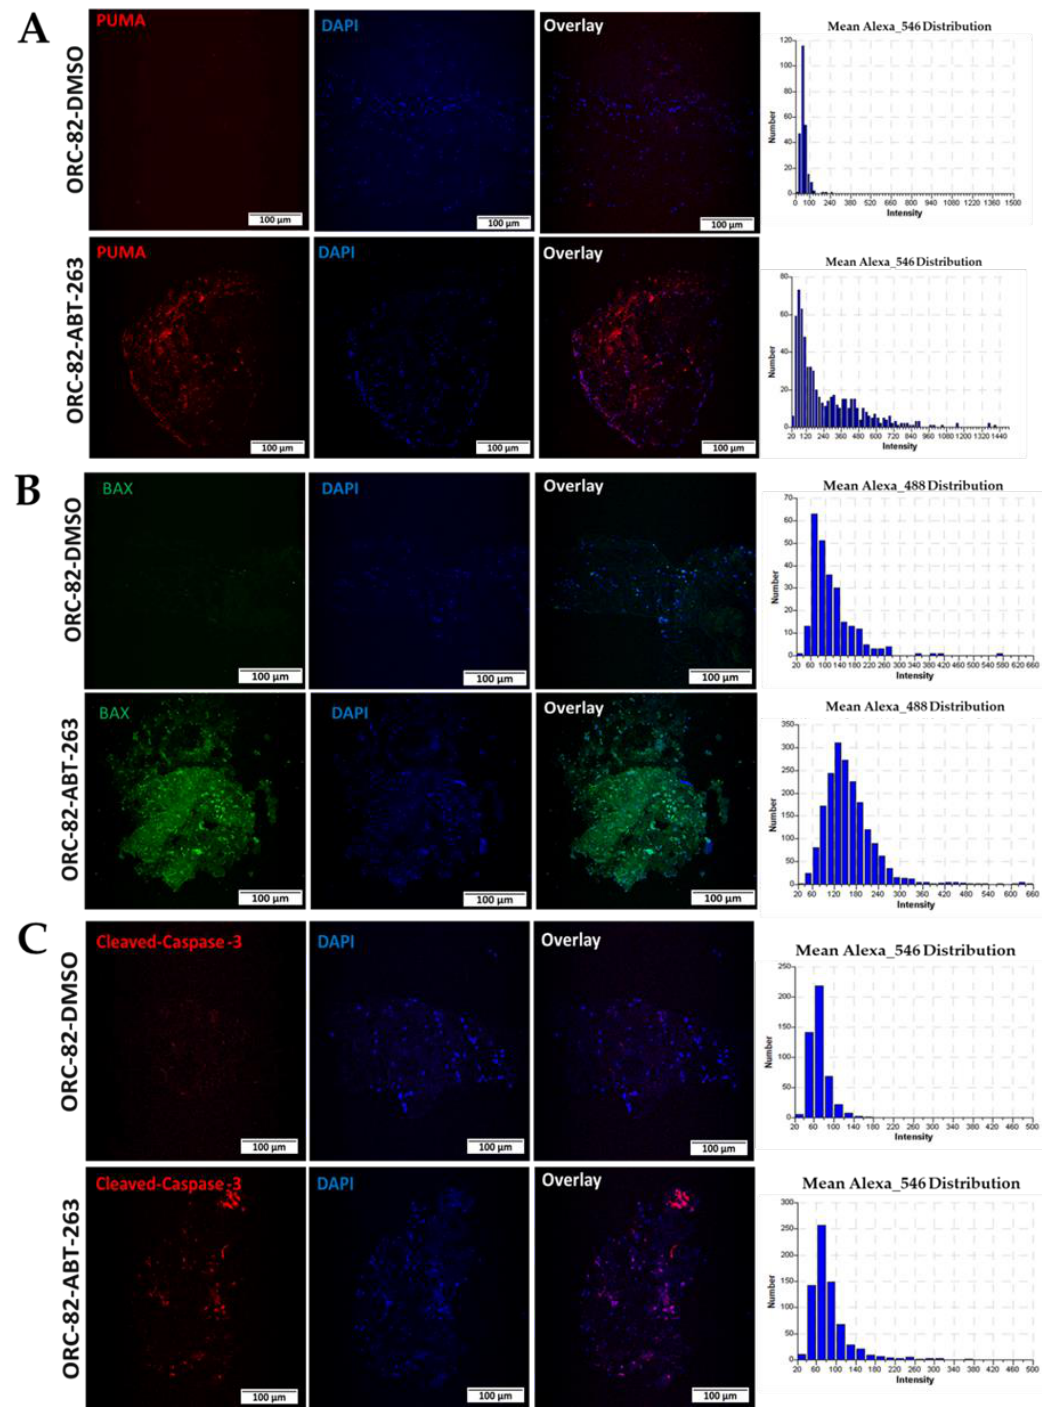
Figure 7. ABT-263 treatment in organoid raft cultures induces apoptosis by increasing PUMA and by activating BAX and cleaved-caspase 3. ( A ) Higher expression of PUMA (red staining), ( B ) BAX (green staining), and ( C ) cleaved-caspase 3 (red staining) were noted after ABT-263 treatment (ORC-82-ABT-263) as compared with DMSO control treatment (ORC-82-DMSO). The same sections that were presented in Figure 5 were costained for proapoptotic proteins, as described in methods Section 4.12. Nuclei (blue) were stained by DAPI; quantification of immunofluorescence signals are represented in bar diagrams; and all images are at 10× magnification (scale bar: 100 µm).